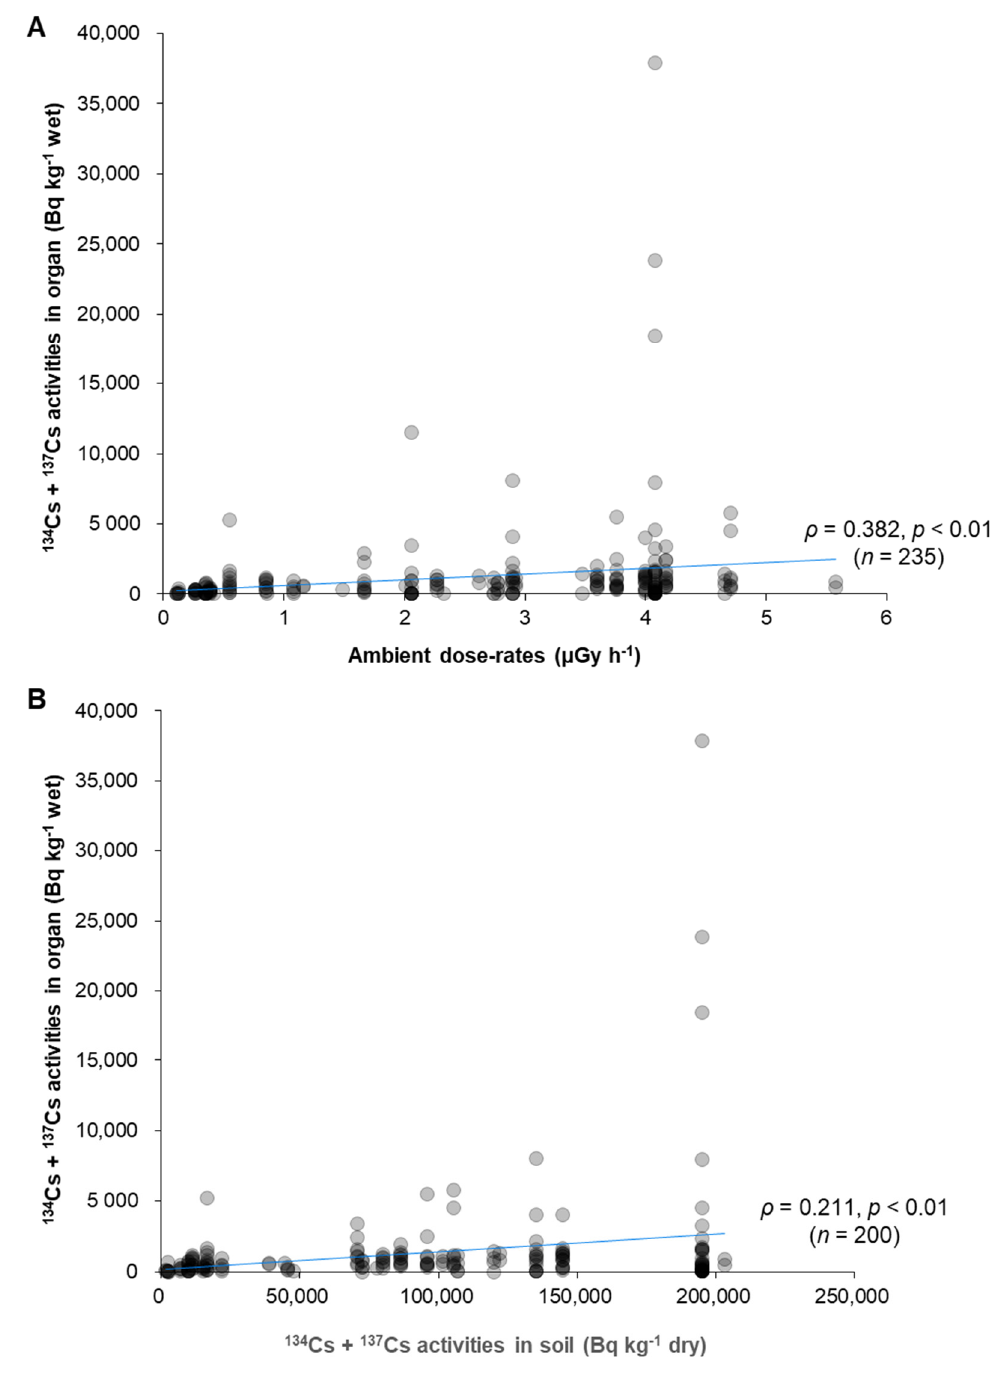
Figure 4. 134 Cs + 137 Cs activity concentrations in reproductive organs of cats compared with ( A ) ambient dose-rates and ( B ) 134 Cs + 137 Cs activity concentrations in soil. Grey dots represent individual 134 Cs + 137 Cs activity concentrations in reproductive organs.